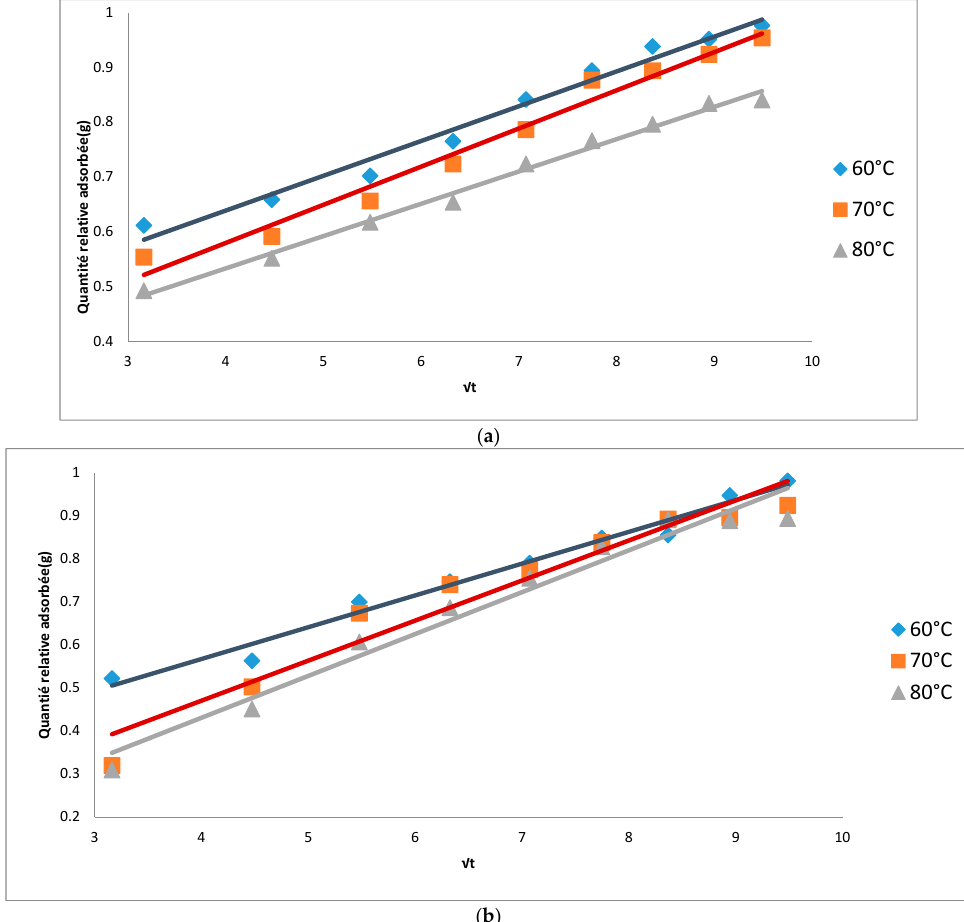
Figure 3. ( a ) Intra particle diffusion kinetic model for the decolorization process using AC from cotton; ( b ) Intra particle diffusion kinetic model for the decolorization process using AC from neem.